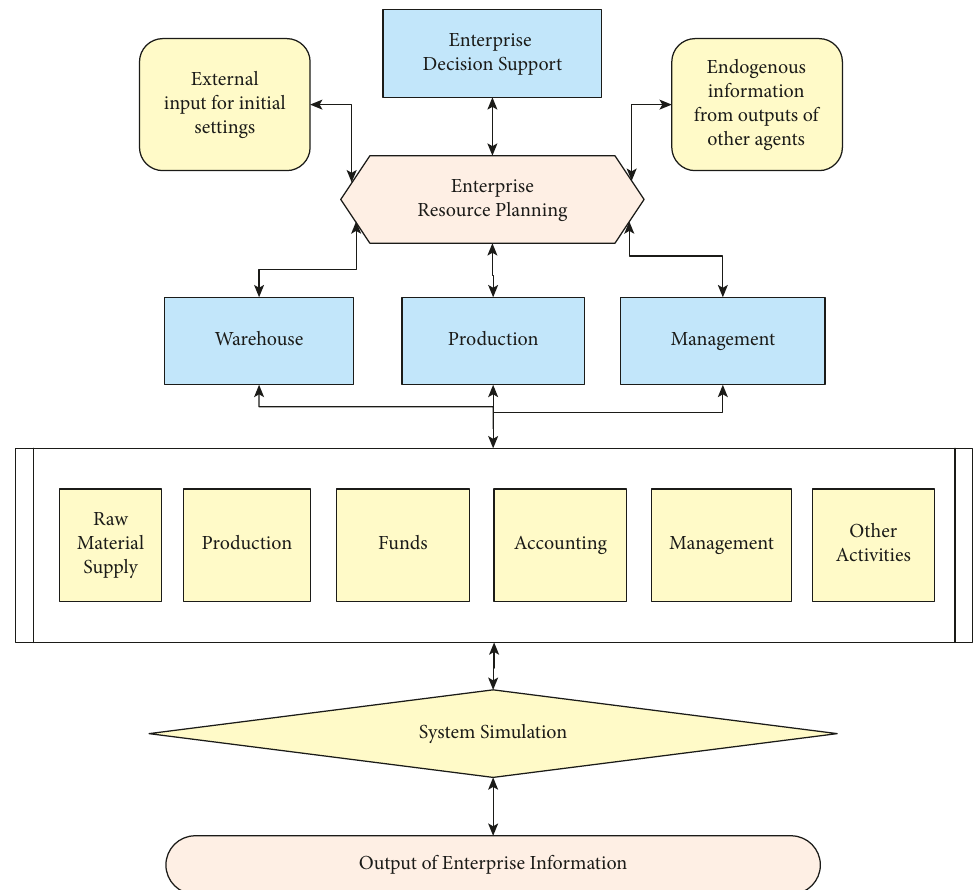
Figure 2: Overview of the process and structure of enterprise system (source: Guangzhou Milestone Software Co., Ltd., China).